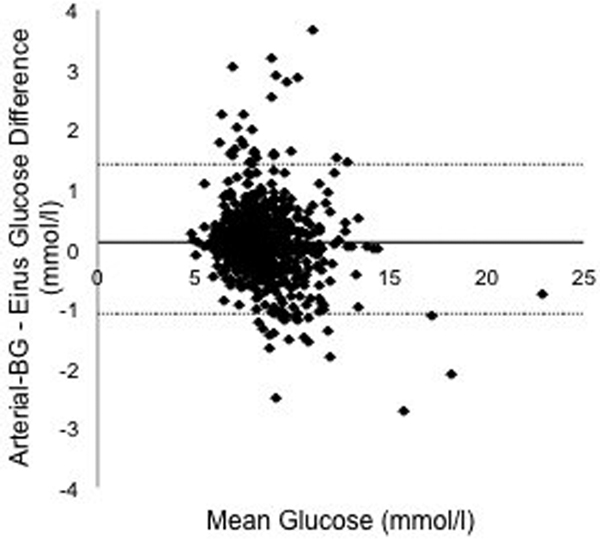
Bland-Altman analysis.